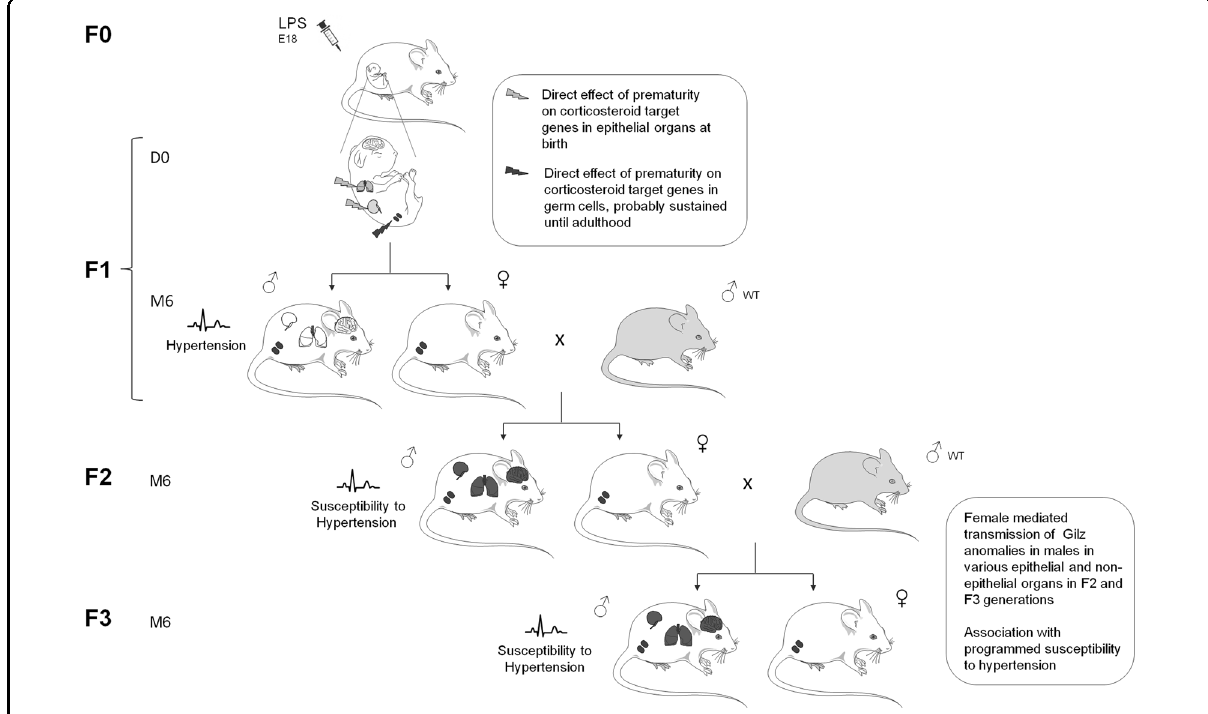
Fig. 7 Model of the hypothetical transmission mechanisms of Gilz alterations observed from the fi rst generation (F1) to the third generation (F3). Potential differential parallel induction of Gilz alterations in somatic cells and germ cells in F1 mice. Considering the germ cell- mediated mode of transmission, these alterations were found in all investigated organs (kidney, brain, and lung) in the F2 and F3 males. These Gilz alterations were associated with the transmission of dysregulated blood pressure up to the third generation after a premature birth. LPS: lipopolysaccharides, E18: 18 days of gestation, D0: fi rst day of life, M6: 6 postnatal months, WT: wild type, F1: fi rst generation, F2: second generation, F3: third